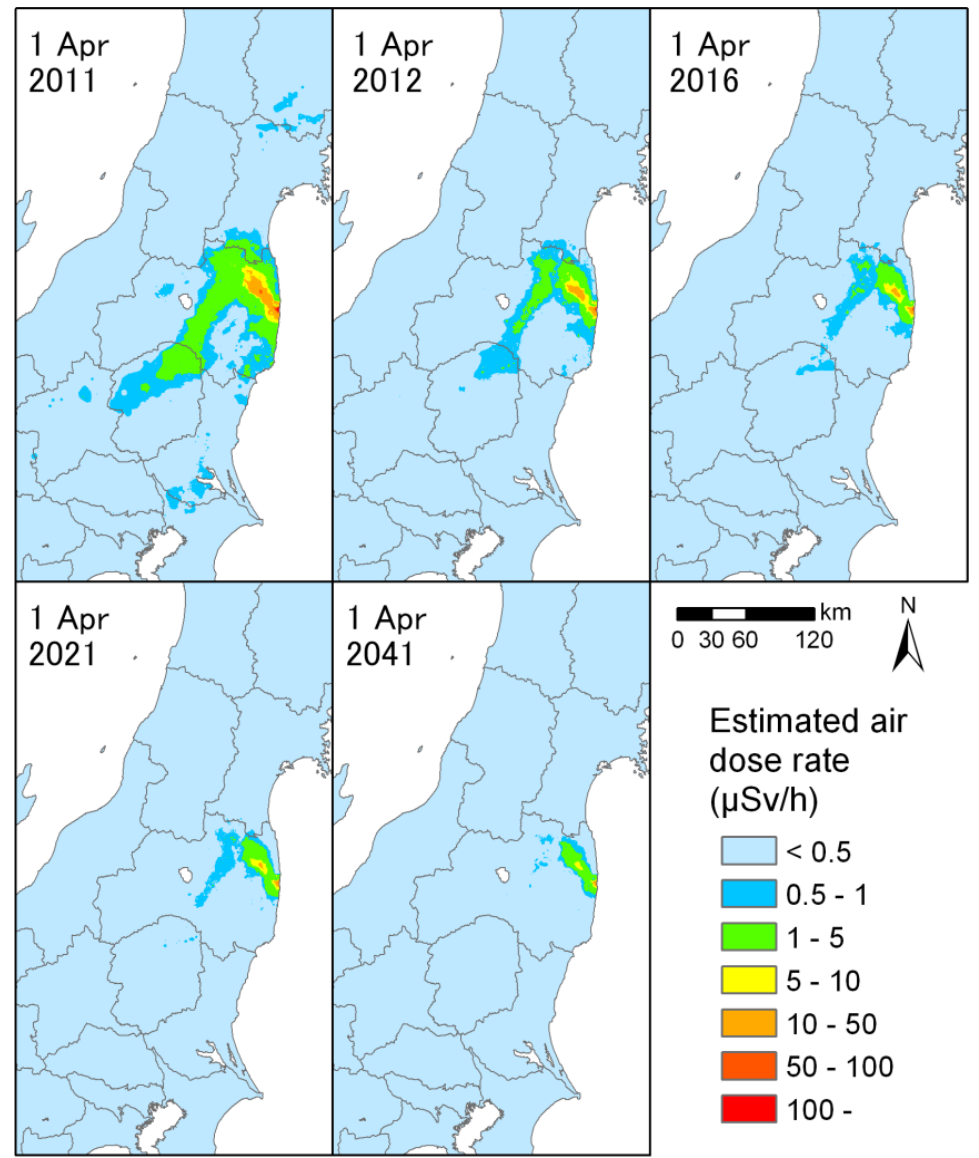
Figure 2. The 30-year air dose rate forecast (µSv/h) for 2011–2041. The map was made by converting the dose rates from the 11,824 measurement points using the inverse distance weighted